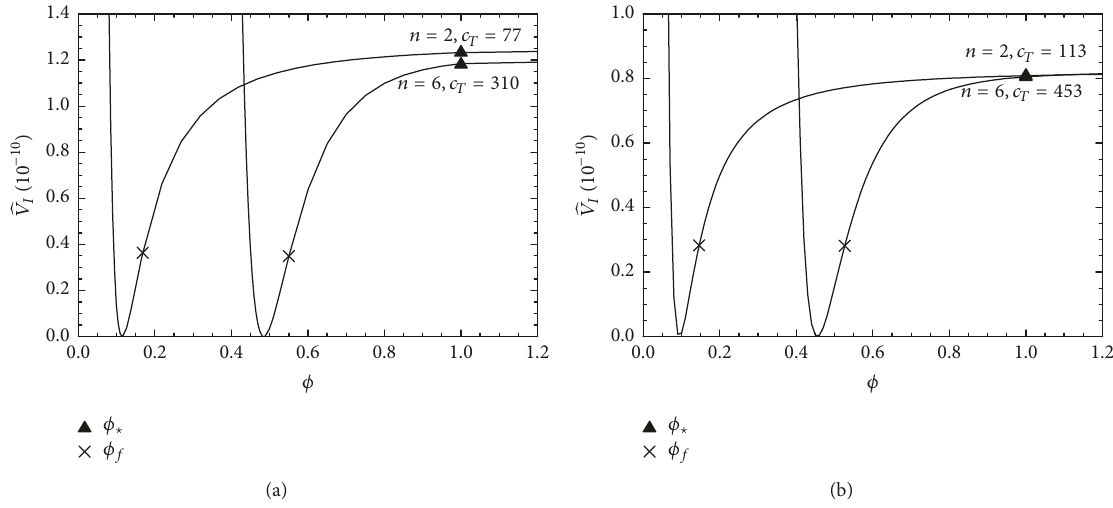
̂ 𝑉 𝜙 for 𝜙 = 1 and 𝑛 = 2 or 𝑛 = 6 . We set (a) 𝐾 = 𝐾 𝐼 as a function of ⋆